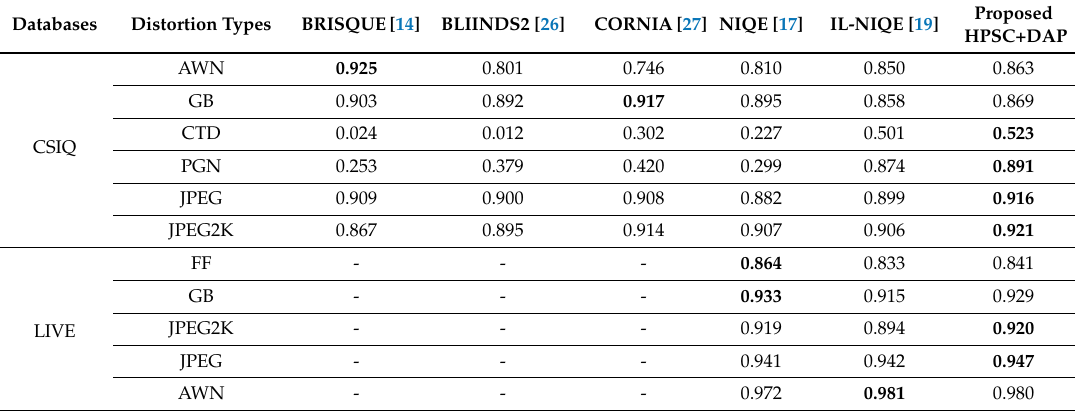
Table 5. The SRCC of BIQA models on each individual distortion type. The best results are highlighted in